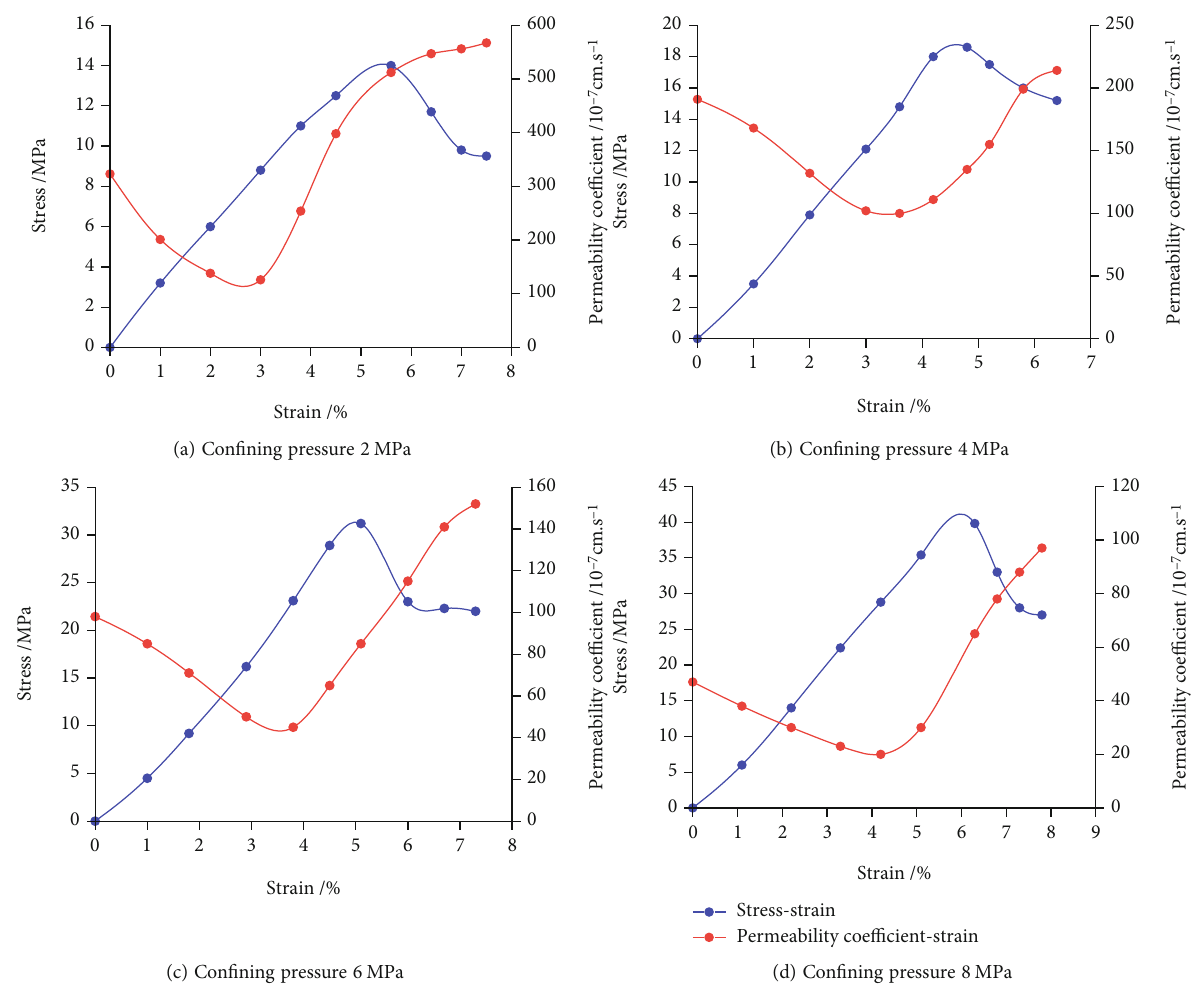
Figure 3: Variation curve of permeability coe ffi cient during stress-strain process. Table 2: Results of penetration